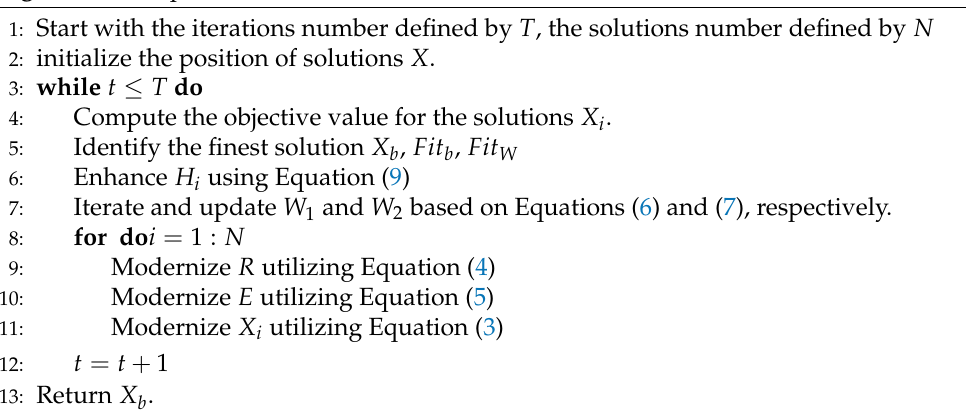
Algorithm 1 Steps of HGS